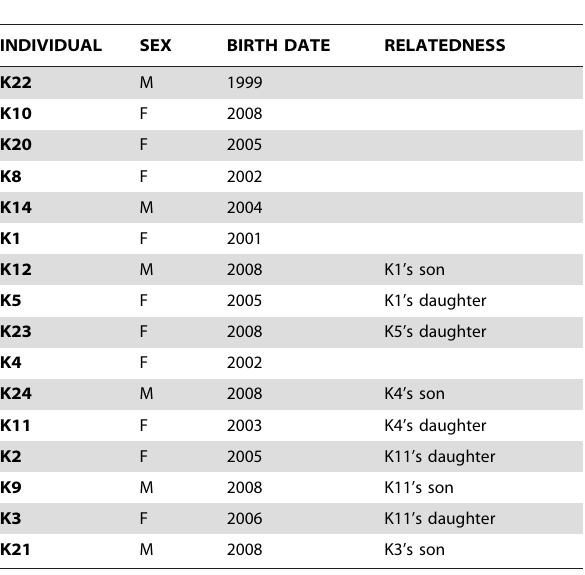
Table 1. The composition of red-necked wallaby colony hosted at the Tierparc Zoo